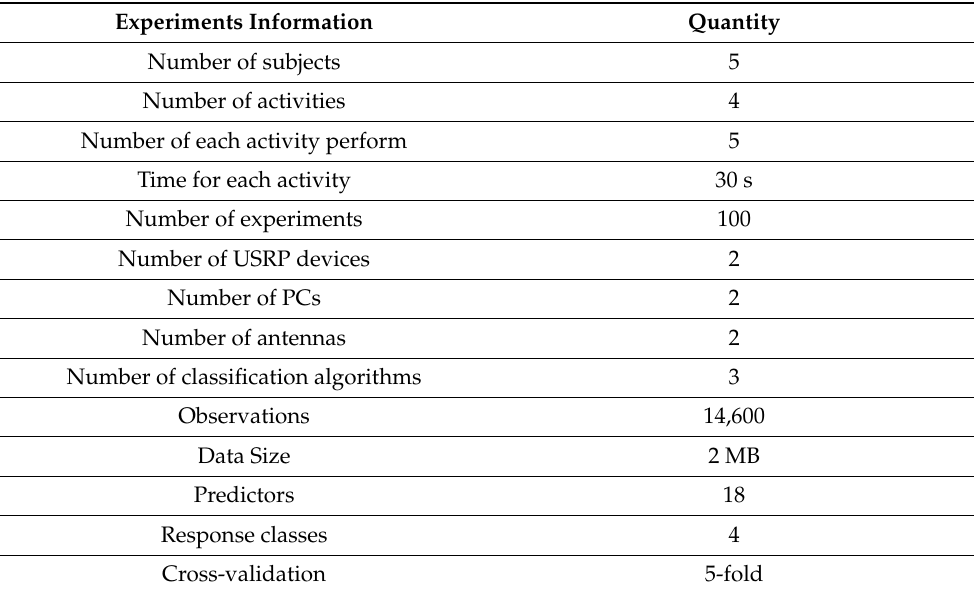
Table 5. Information on the conducted breathing